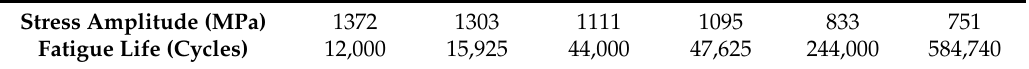
Table 1. The loading stress amplitudes and their fatigue lives.